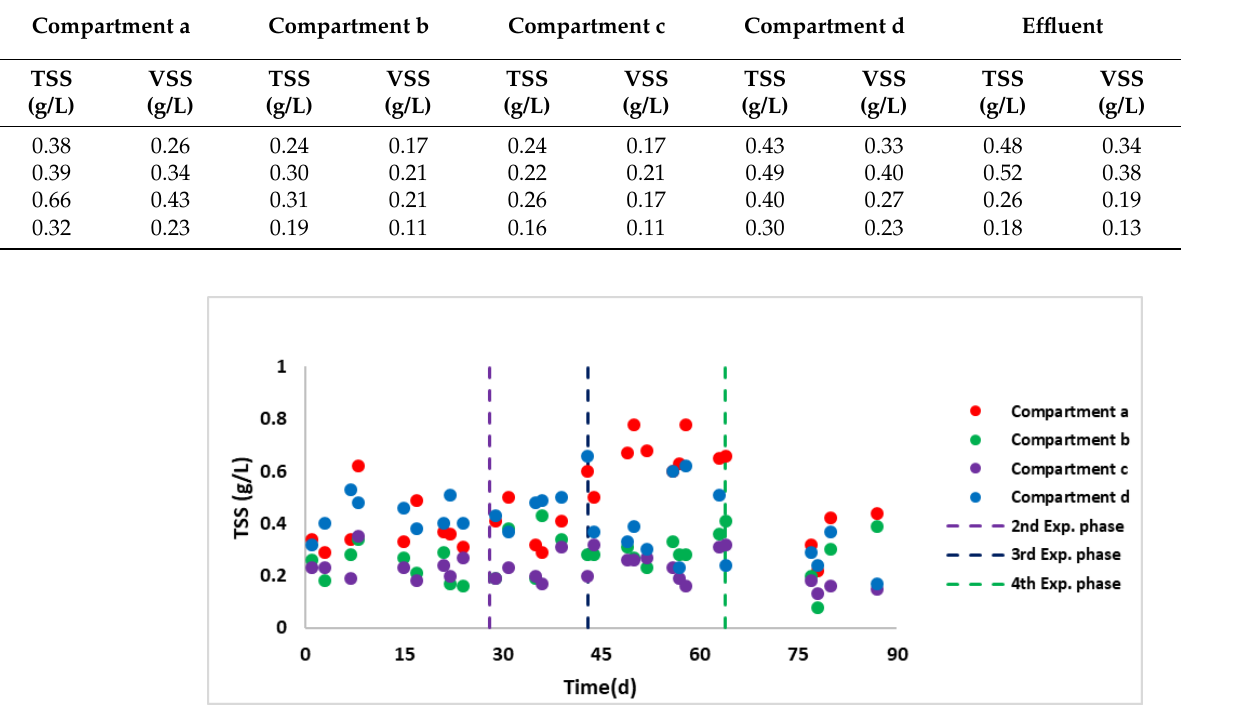
Figure 17 . Daily TSS concentration in the reactor ’ s compartments. Figure 17. Daily TSS concentration in the reactor’s compartments.